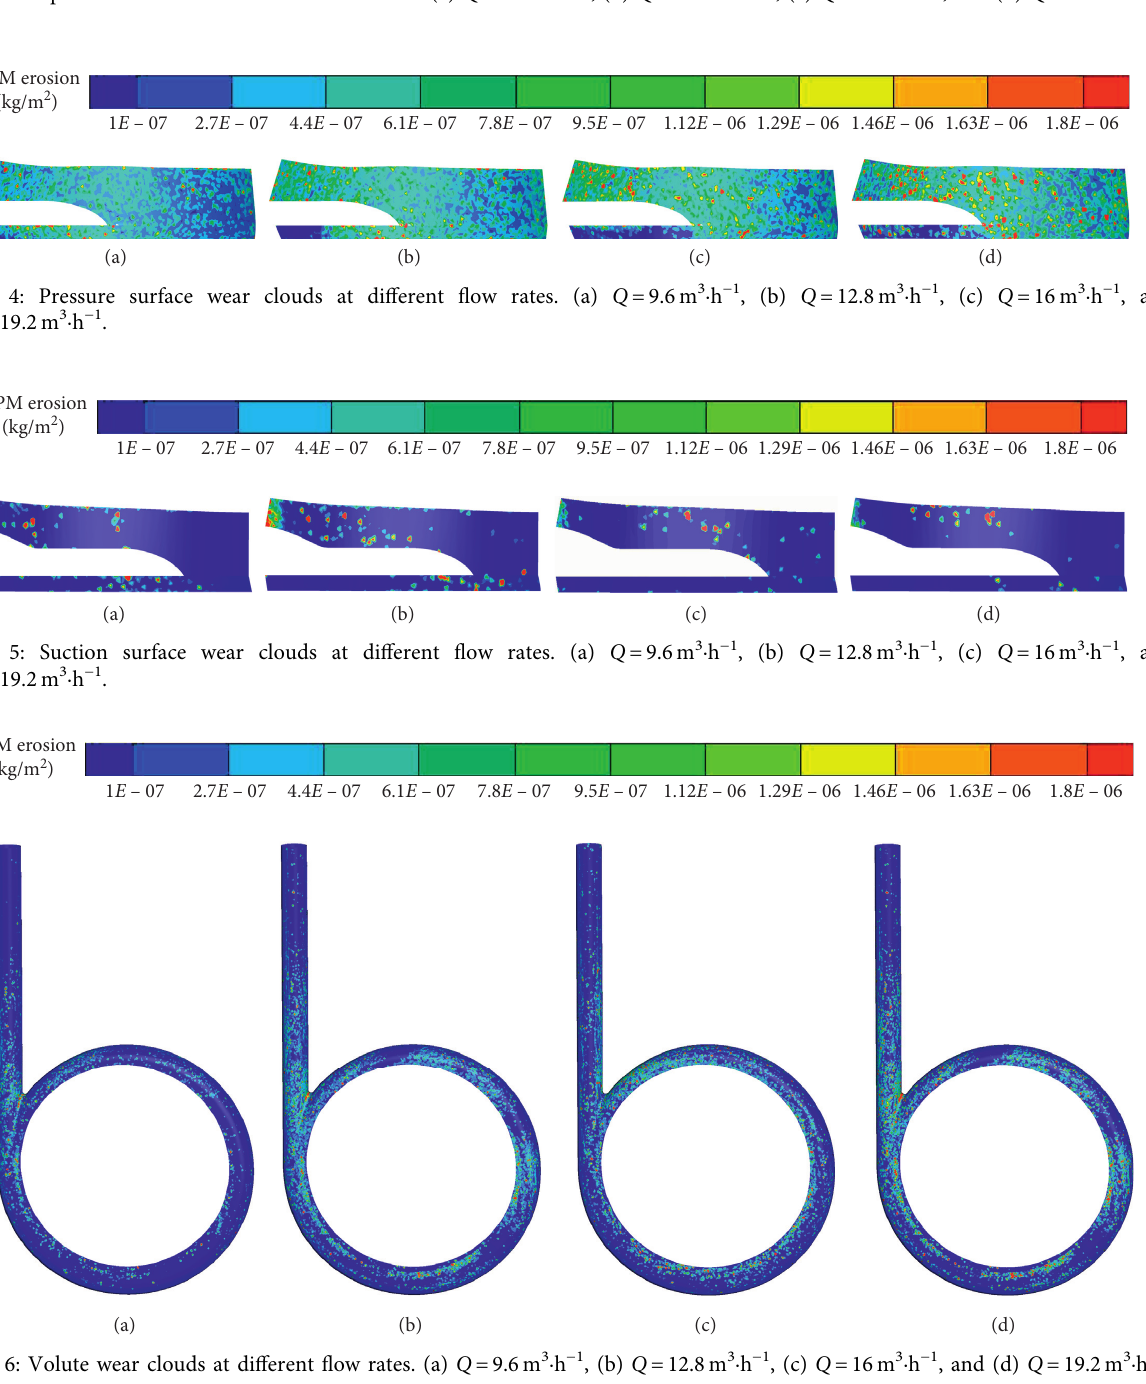
Figure 3: Impeller wear clouds at different flow rates. (a) Q � 9.6m 3 · h − 1 , (b) Q � 12.8m 3 · h − 1 , (c) Q � 16m 3 · h − 1 , and (d) Q � 19.2m 3 · h − 1 .